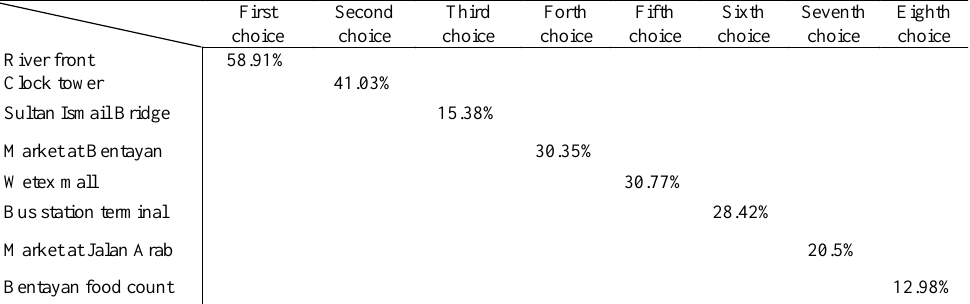
Table 3: Degree of orientation between notable places in Muar